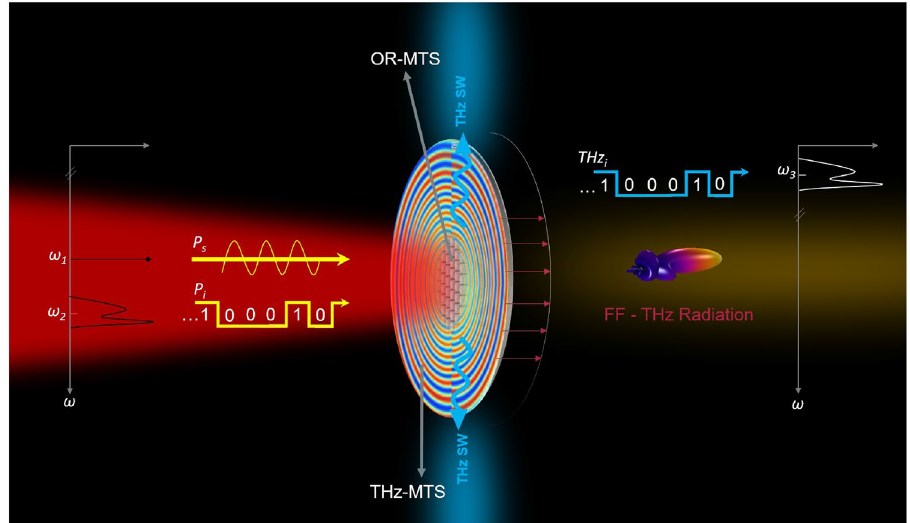
Figure 1. The wavelength converter: the information message, with power P i , mixes with the incident signal, power P s , both in the IR region. DFG in the all–dielectric nanoantennas emitting the THz information signal, THz i , to produce a THz surface wave (SW) which propagates in the surrounding THz metasurface where it is converted into the desired THz radiation in the far-field (FF). The FF plot is created by using